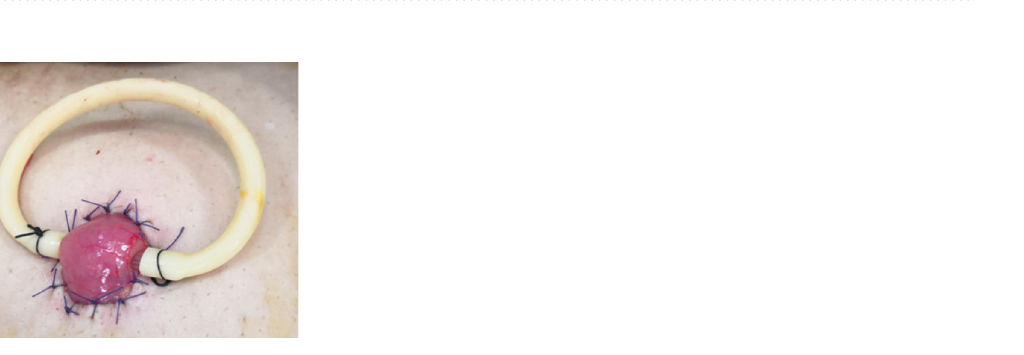
Figure 4. Appearance of the traditional loop